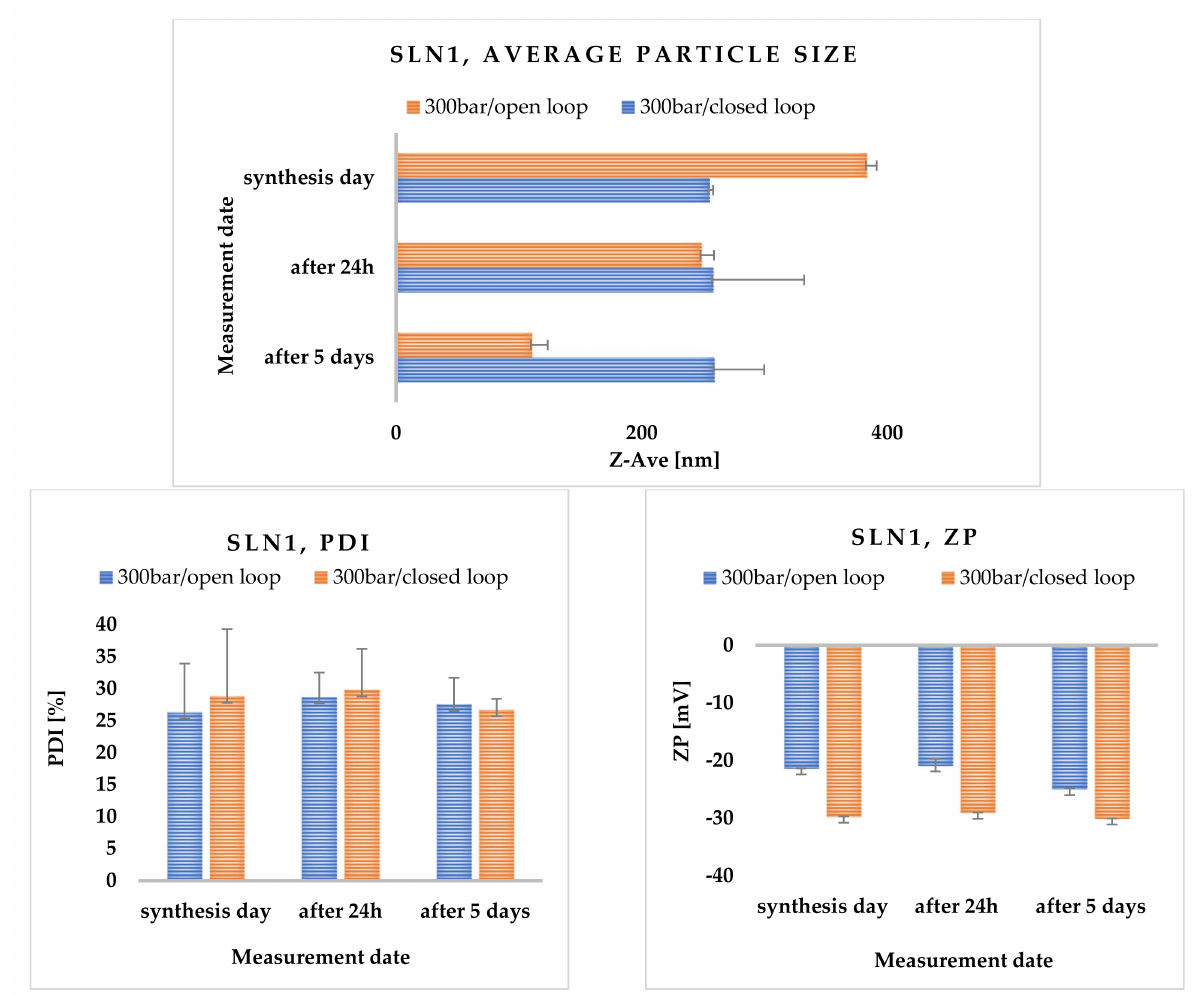
Figure 4. Comparison of average particle size, polydispersity index (PDI) and zeta potential (ZP) of nanoparticles synthesized with Softisan ® 601 lipid and Poloxamer 188 at 300 bar, measured on the day of synthesis, and additionally 24 h and 5 days after the synthesis. The process of obtaining nanoparticles was carried out in an open- and closed-loop systems in three